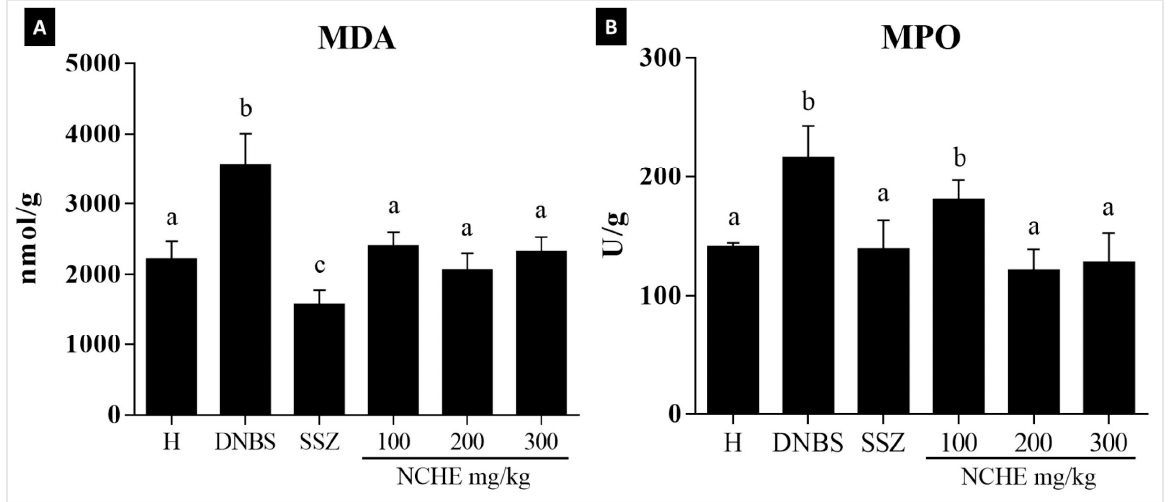
Figure 4. Effect of N. cochenillifera hydroethanolic extract (NCHE) (100, 200 and 300 mg/kg) and sulfasalazine (SSZ) (250 mg/kg) on colonic ( A ) malondialdehyde (MDA) levels and ( B ) myeloperoxidase activity. H: Healthy group. Data are expressed as means ± SEM. Groups with a different letter differ statistically ( p < 0.05).